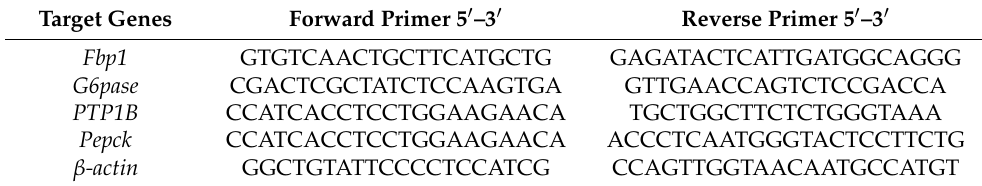
Table 1. Primer sequences used for